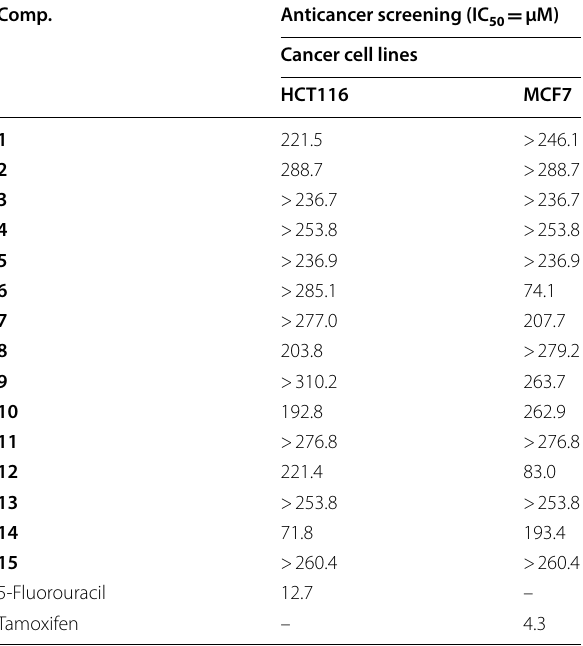
Table 3 In vitro anticancer screening of the synthesized compounds